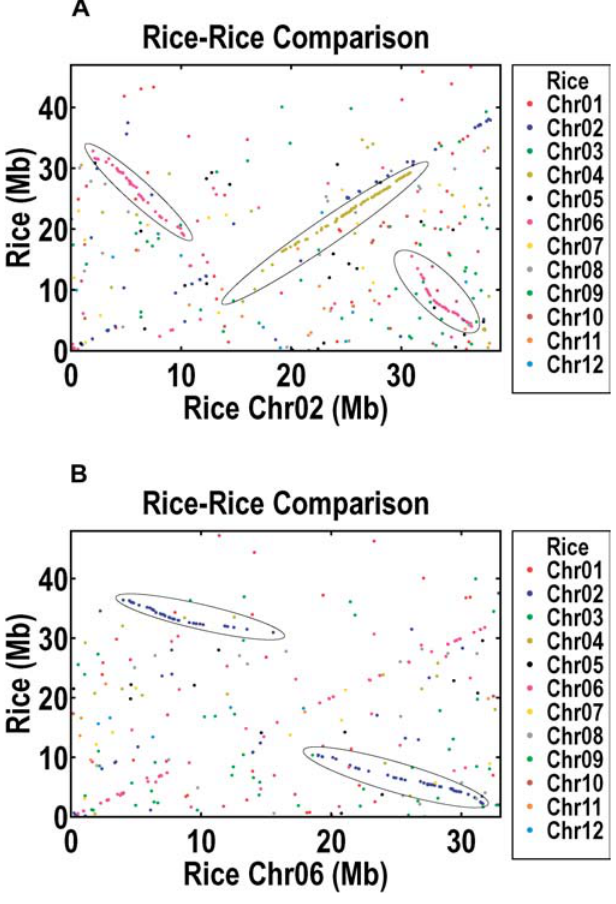
Figure 6. Duplicated Segments in the Beijing indica Assembly Depicted here are the plots for Chromosomes 2 (A) and 6 (B). Each data point represents the coordinated genomic positions in a homolog pair, consisting of one nr-KOME cDNA and its one and only TBlastN homolog in rice. Shown on the x -axis is the position of a gene on the indicated chromosome, and shown on the y -axis is the position of its homolog on any of the rice chromosomes, with chromosome number encoded by the colors indicated on the legend at the right.